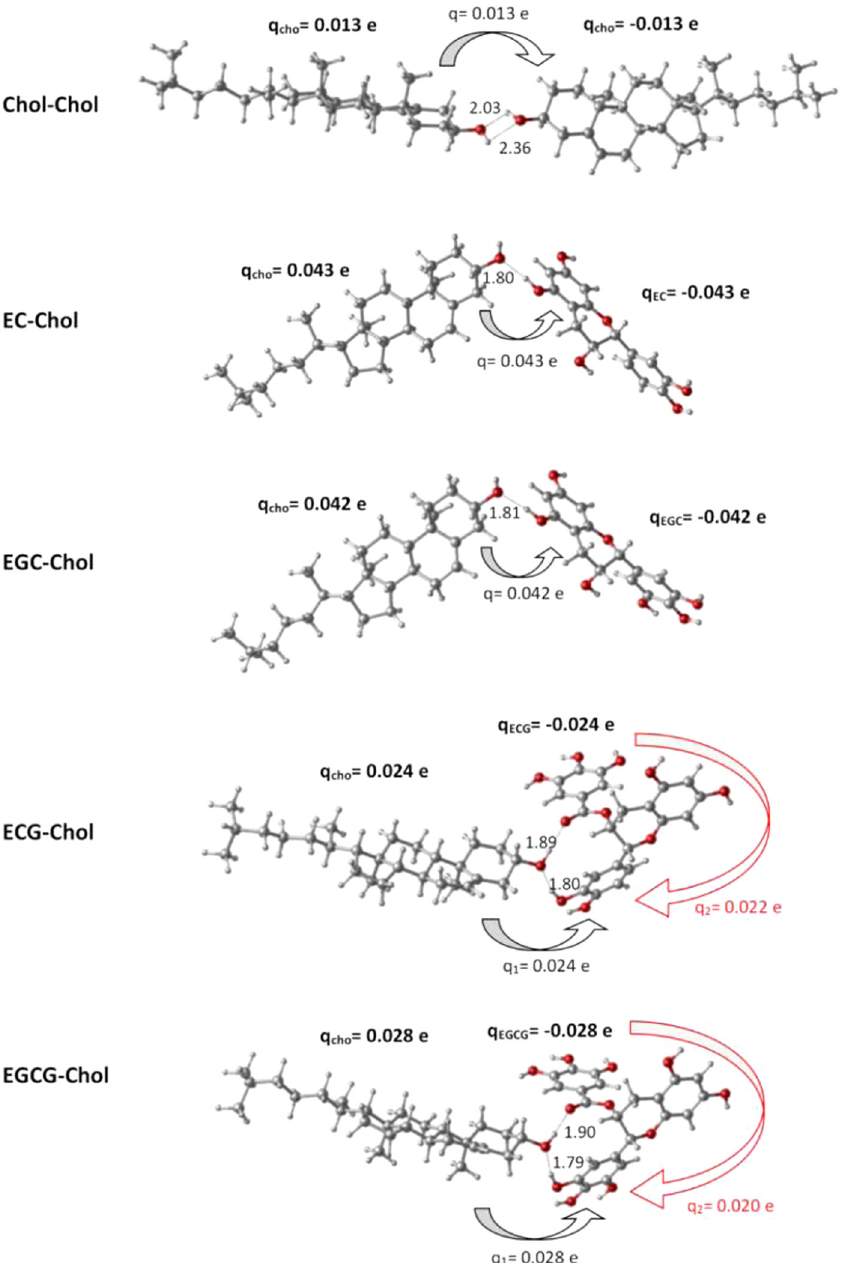
Figure 5: Molecular structures of EC – cholesterol ( EC – Chol ) , EGC – cholesterol ( EGC – Chol ) , ECG – cholesterol ( ECG – Chol ) , EGCG – cholesterol ( EGCG – Chol ) and cholesterol – cholesterol ( Chol – Chol ) ( the black arrows represent intermolecular charge transfer and the red arrows represent intramolecular charge transfer )